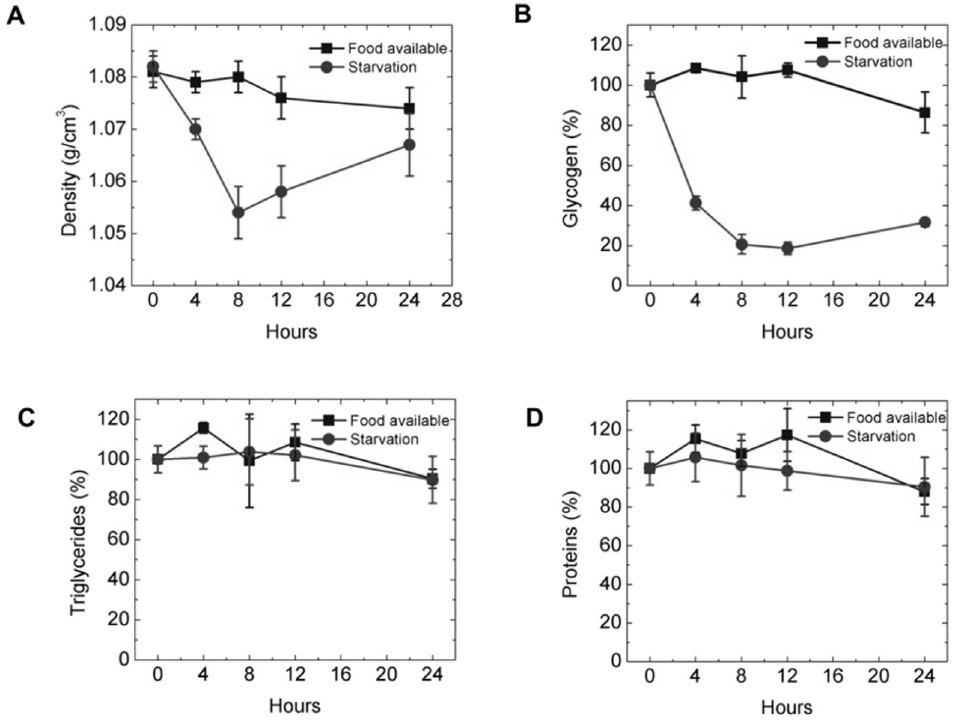
Figure 4. The change in density of starved worms correlates with the consumption of glycogen. (A) Densities of worms with ample food and under starvation. (B,C) Percentage of macronutrients—glycogen, triglycerides and proteins— normalized with respect to the values measured at t=0 hours. The decrease in density correlated with the depletion of glycogen in the starved worms.